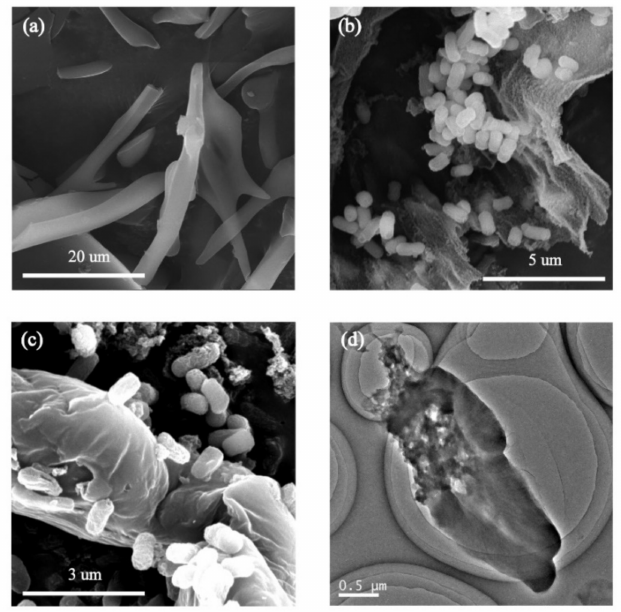
Figure 8. SEM of GORs ( a ) and E. coli exposed to GORs in 50 µ g/mL ( b ) and 200 µ g/mL ( c ), and the TEM of E. coli exposed to GORs in 200 µ g/mL ( d ).